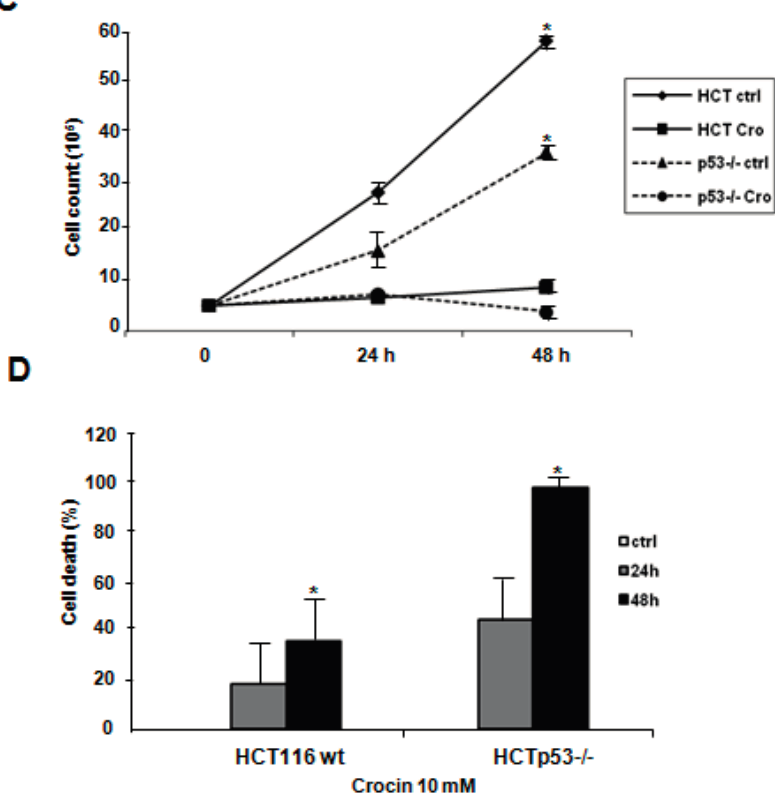
Figure 1. Effect of increasing concentrations of crocin on the growth of HCT116 wild-type (wt) and HCT116 p53 − / − cells for 24 and 48 h. ( A , B ) Viability test assessed by 3-(4,5-dimethylthiazol-2-yl)-2,5-diphenyltetrazolium bromide (MTT) showing the HCT116 wild-type and HCT116 p53 − / − cells untreated (ctrl) or treated with different concentrations of crocin (Cro; 0.5 to 15 mM) for 24 and 48 h. The MTT data shown are performed in quadruplicates; and ( C ) Cell numbers (dead and alive) and ( D ) cell death percentages were measured using the trypan blue staining after crocin treatment for 24 and 48 h ( * p <